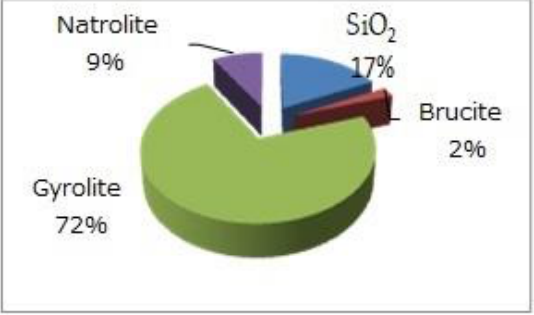
Figure 26. Weight % of solids predicted by thermodynamic simulation at 20 °C. In this simulation precipitation of C-S-H was suppressed.